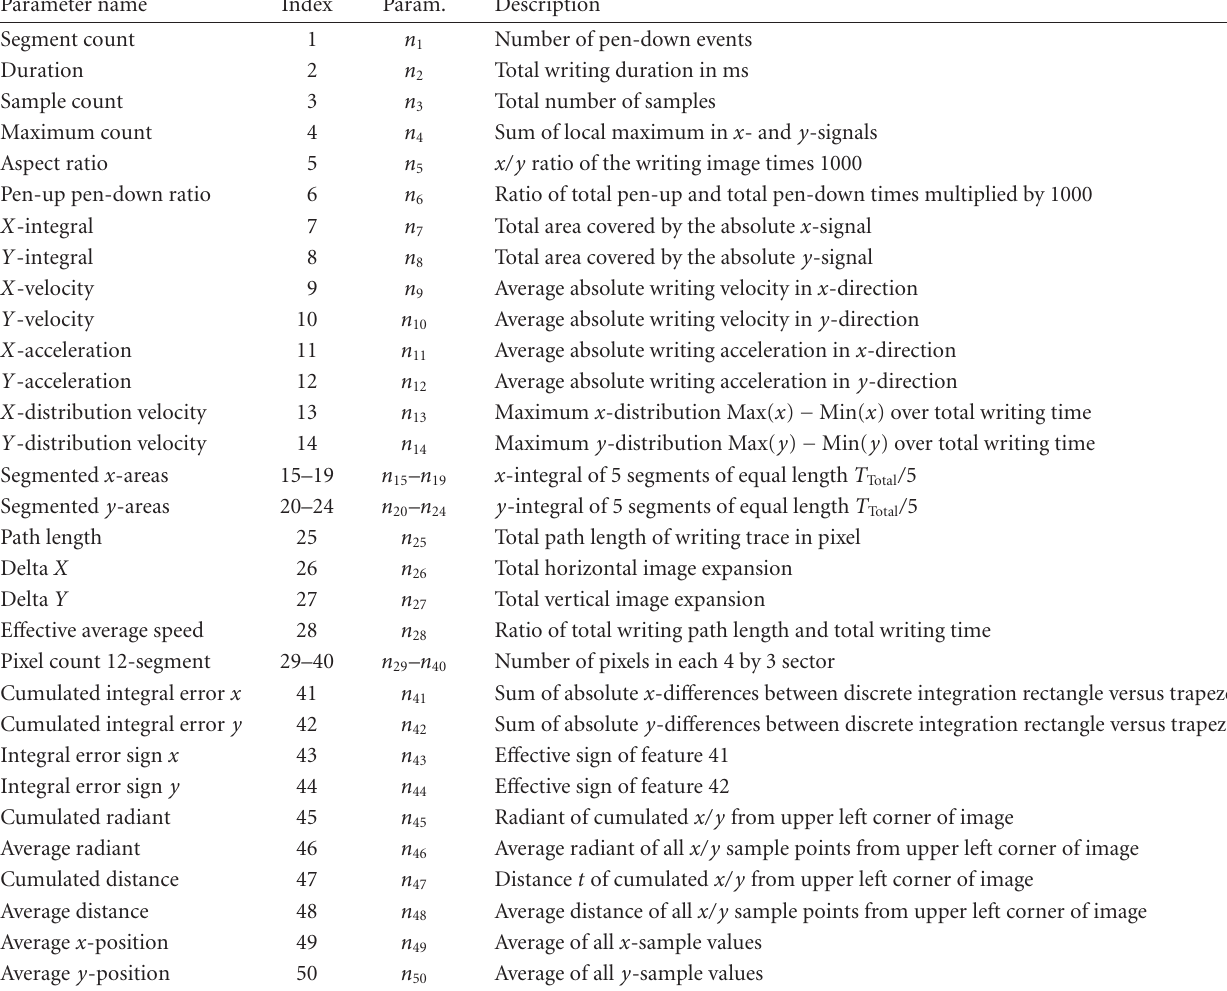
Table 1: Feature parameters for the biometric hash